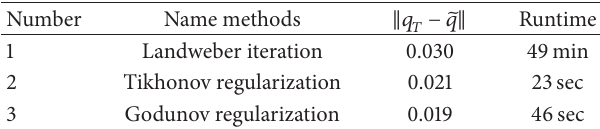
Table 5: Comparative analysis of methods in the case of no noise.